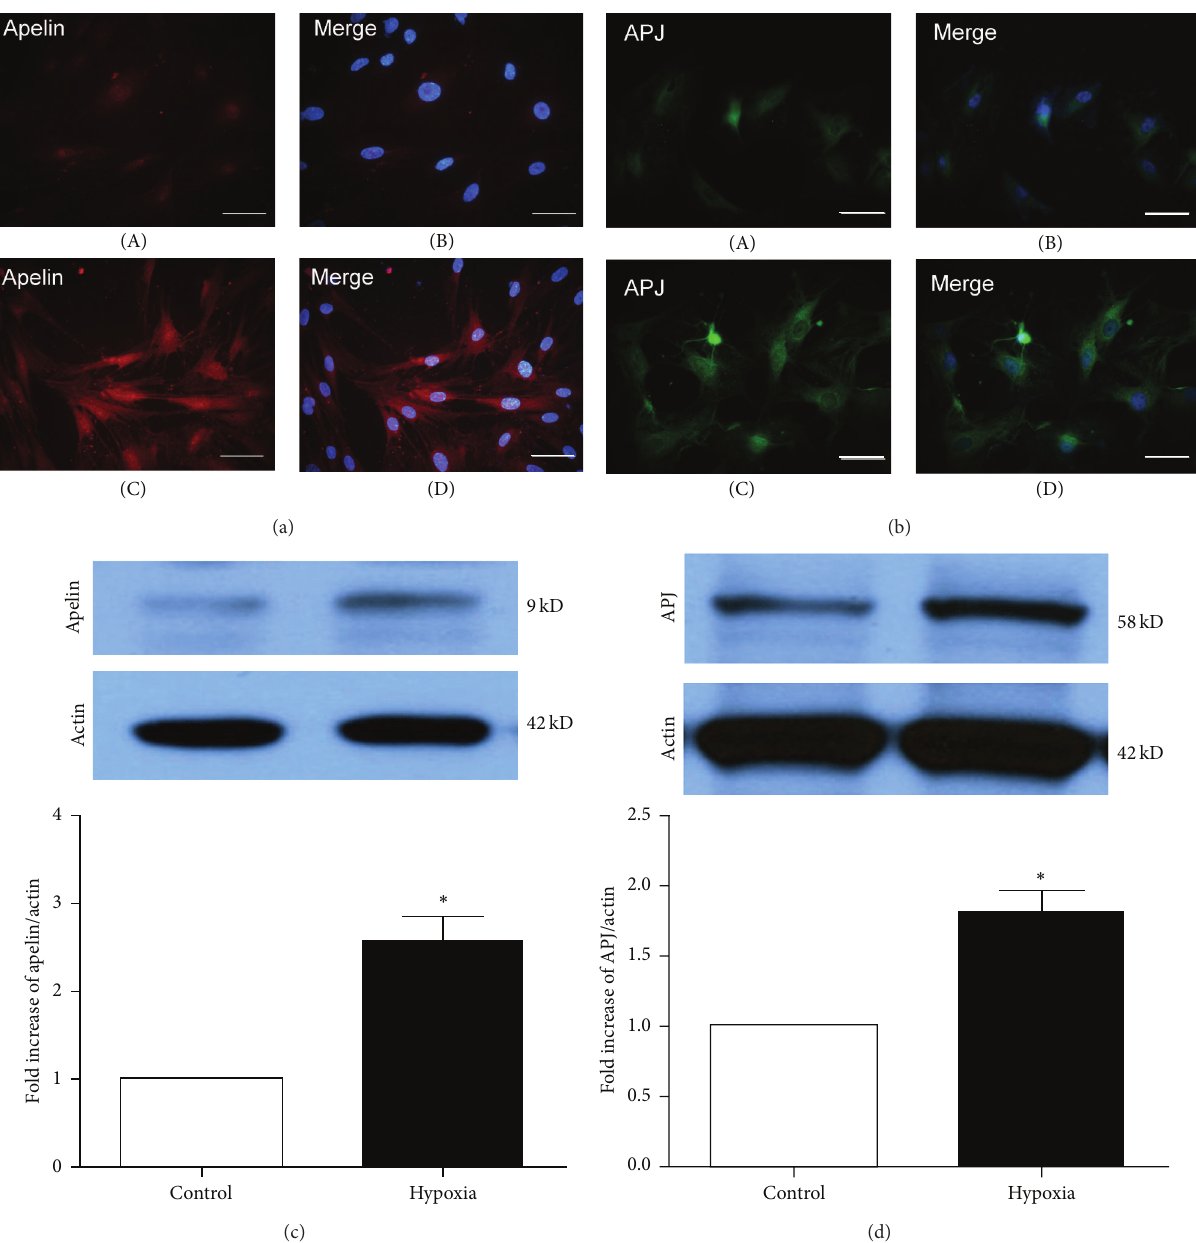
Figure3:Thecellularlocalizationofapelin/APJ.(a)Apelinimmunoreactivitywasfoundweakanddiffusedinthecytoplasmofnormal(A)but showed more intense cytoplasmic staining in hypoxic pericyte (C). Scale bar = 100 𝜇 m. Similarly, (b) compared with restricted cytomembrane expression in normal (A) and hypoxia (C) pericyte, APJ localization expanded and brightened in the cytoplasm and cytoplasm membrane (apelin in red, APJ in green, and DAPI in blue). Scale bar = 100 𝜇 m. (c) and (d) Western blot analysis shows that the expression of apelin and APJ under hypoxia was upregulated 2.5-fold and 1.9-fold, respectively ( 𝑃 < 0.05 ). versus control, ∗∗ 𝑃 < 0.01 ; 1000 ng/mL versus control, ∗ 𝑃 < 0.05